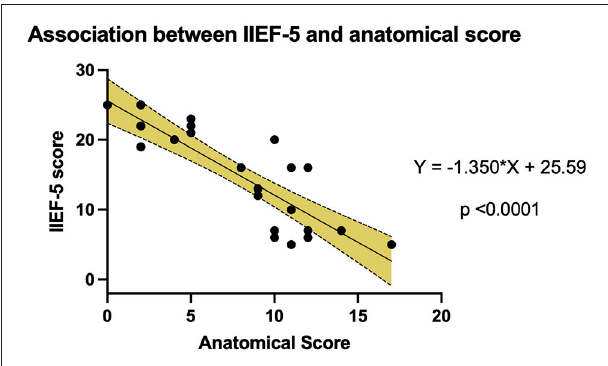
FIGURE 5 | Linear regression analysis correlating IIEF-5 outcomes and the anatomical